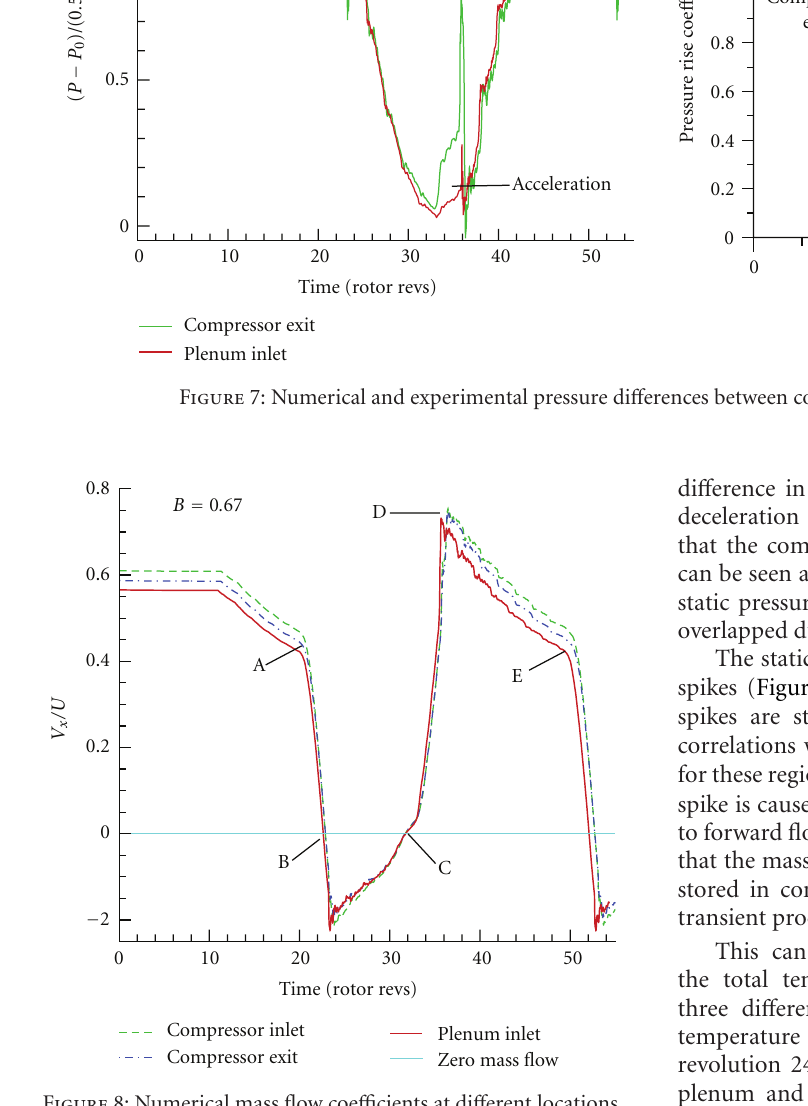
2 takes place when the plenum is repressurized (curve